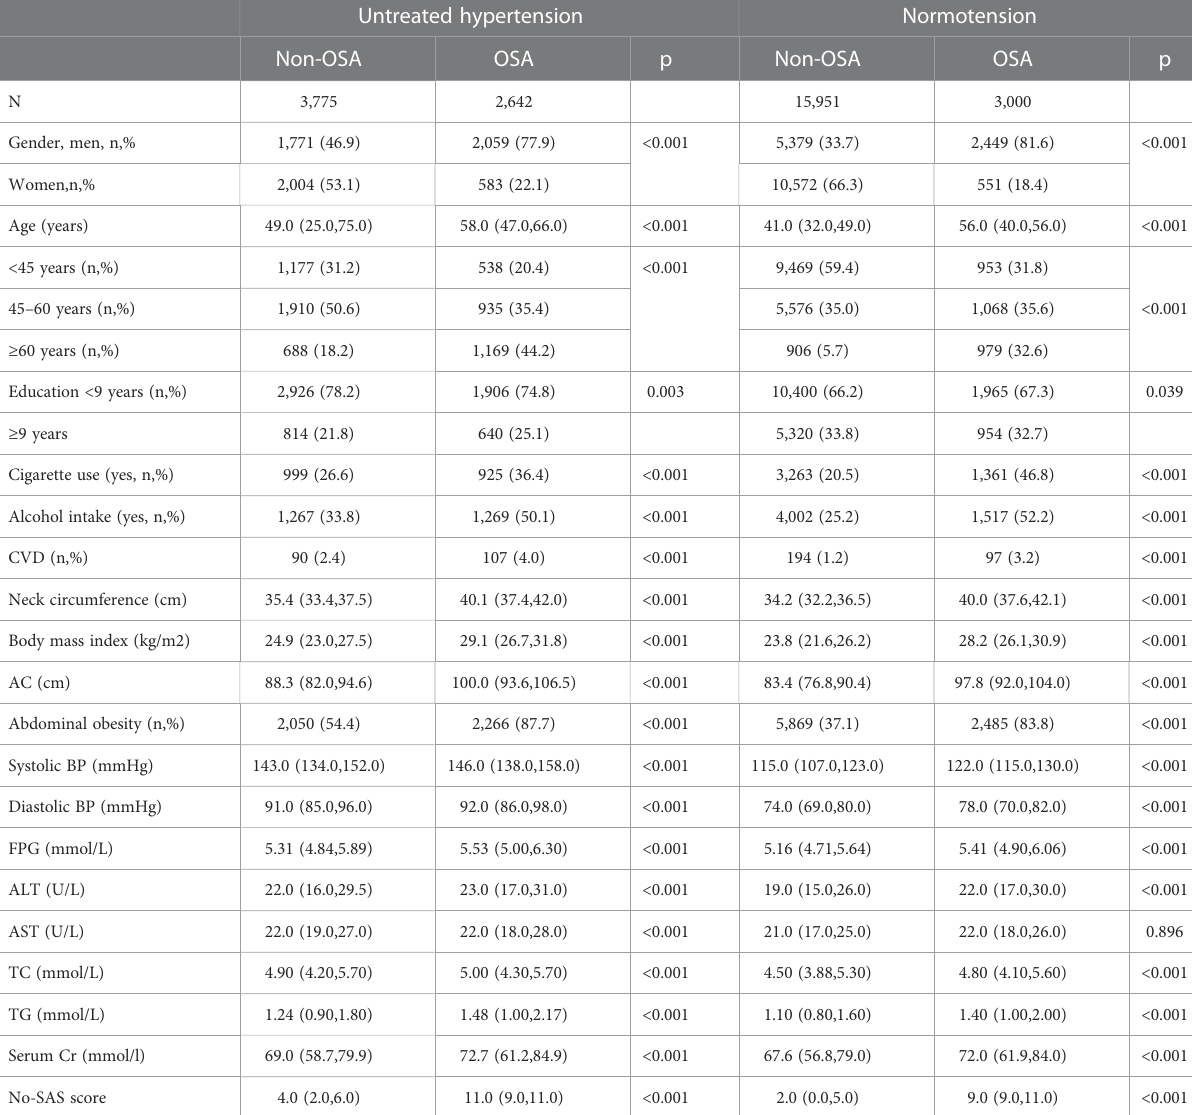
TABLE 4 Characteristics of non-OSA and OSA participants by presence of hypertension in community